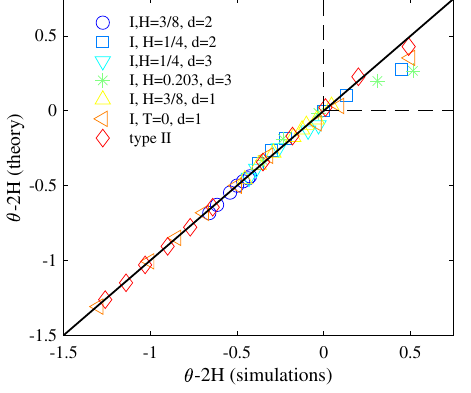
Fig. 4 | Comparison of theoretical values of the persistence exponent versus simulations. For all data shown in Figs. 1, 2,